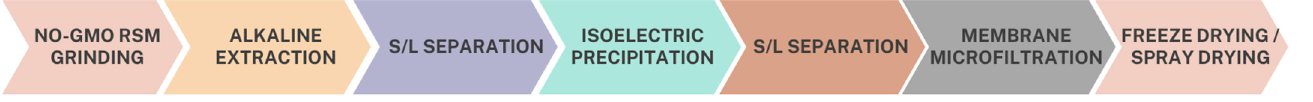
Figure 1. Flow-chart of RSM protein production process. The compositional data of the RSM protein isolates from semi-pilot- and full-pilot-scale trials are reported in Table